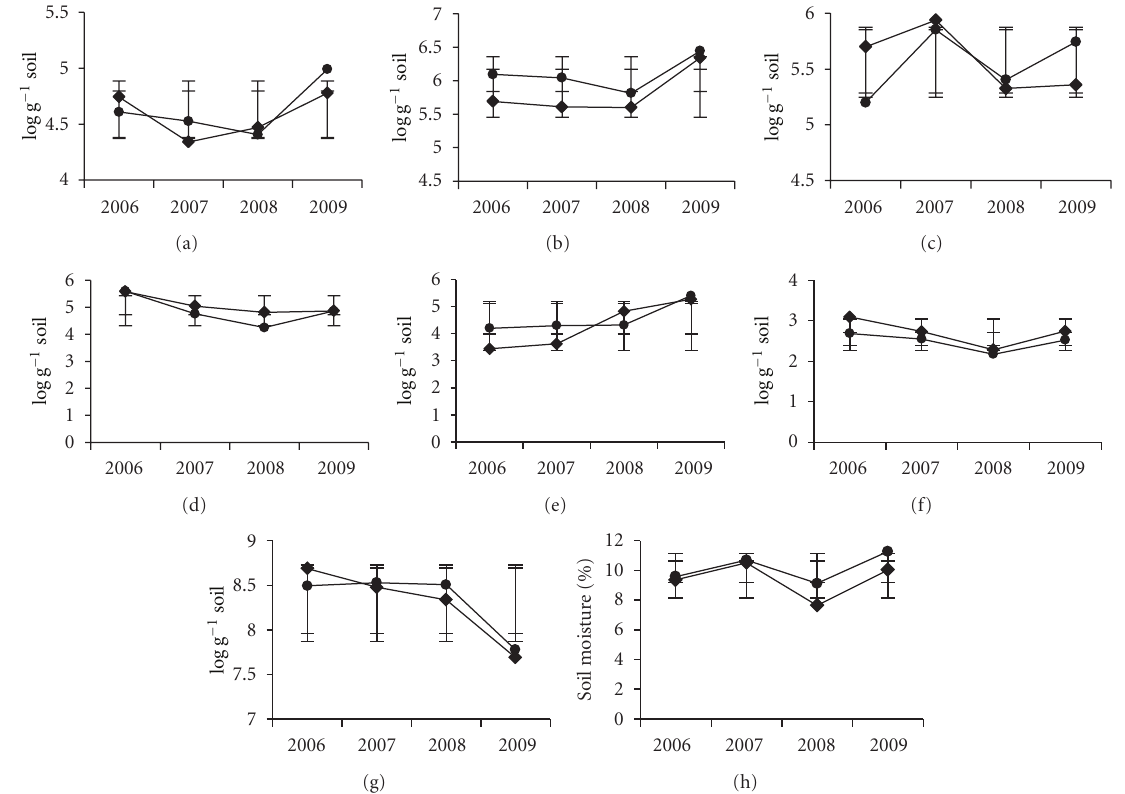
Figure 8: Di ff erences in microbial numbers on a logarithmic scale and soil moisture content of plots subjected to rotation and monoculture during the study period. (a) Nonfilamentous hymenomycetes, (b) filamentous hymenomycetes, (c) actinomycetes, (d) protozoa, (e) filamentous growth, (f) Mucorales, (g) heterotrophic growth, and (h) percentage of soil moisture on day of sampling. Monoculture = M - (cid:2) -; rotation = R - • -. Vertical bars denote standard